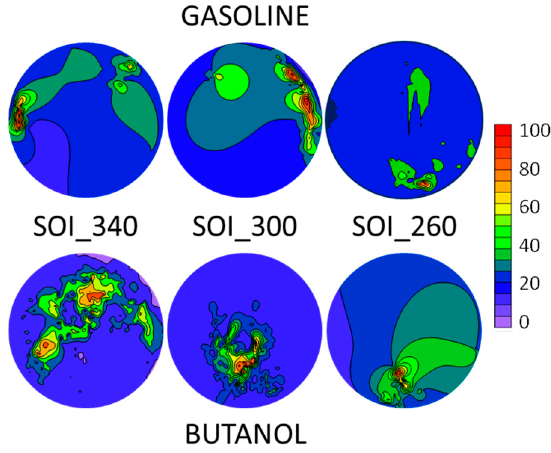
Figure 12. Distribution maps of diffusive flames at 100 CAD after spark timing, built on data recorded over 20 consecutive cycles.